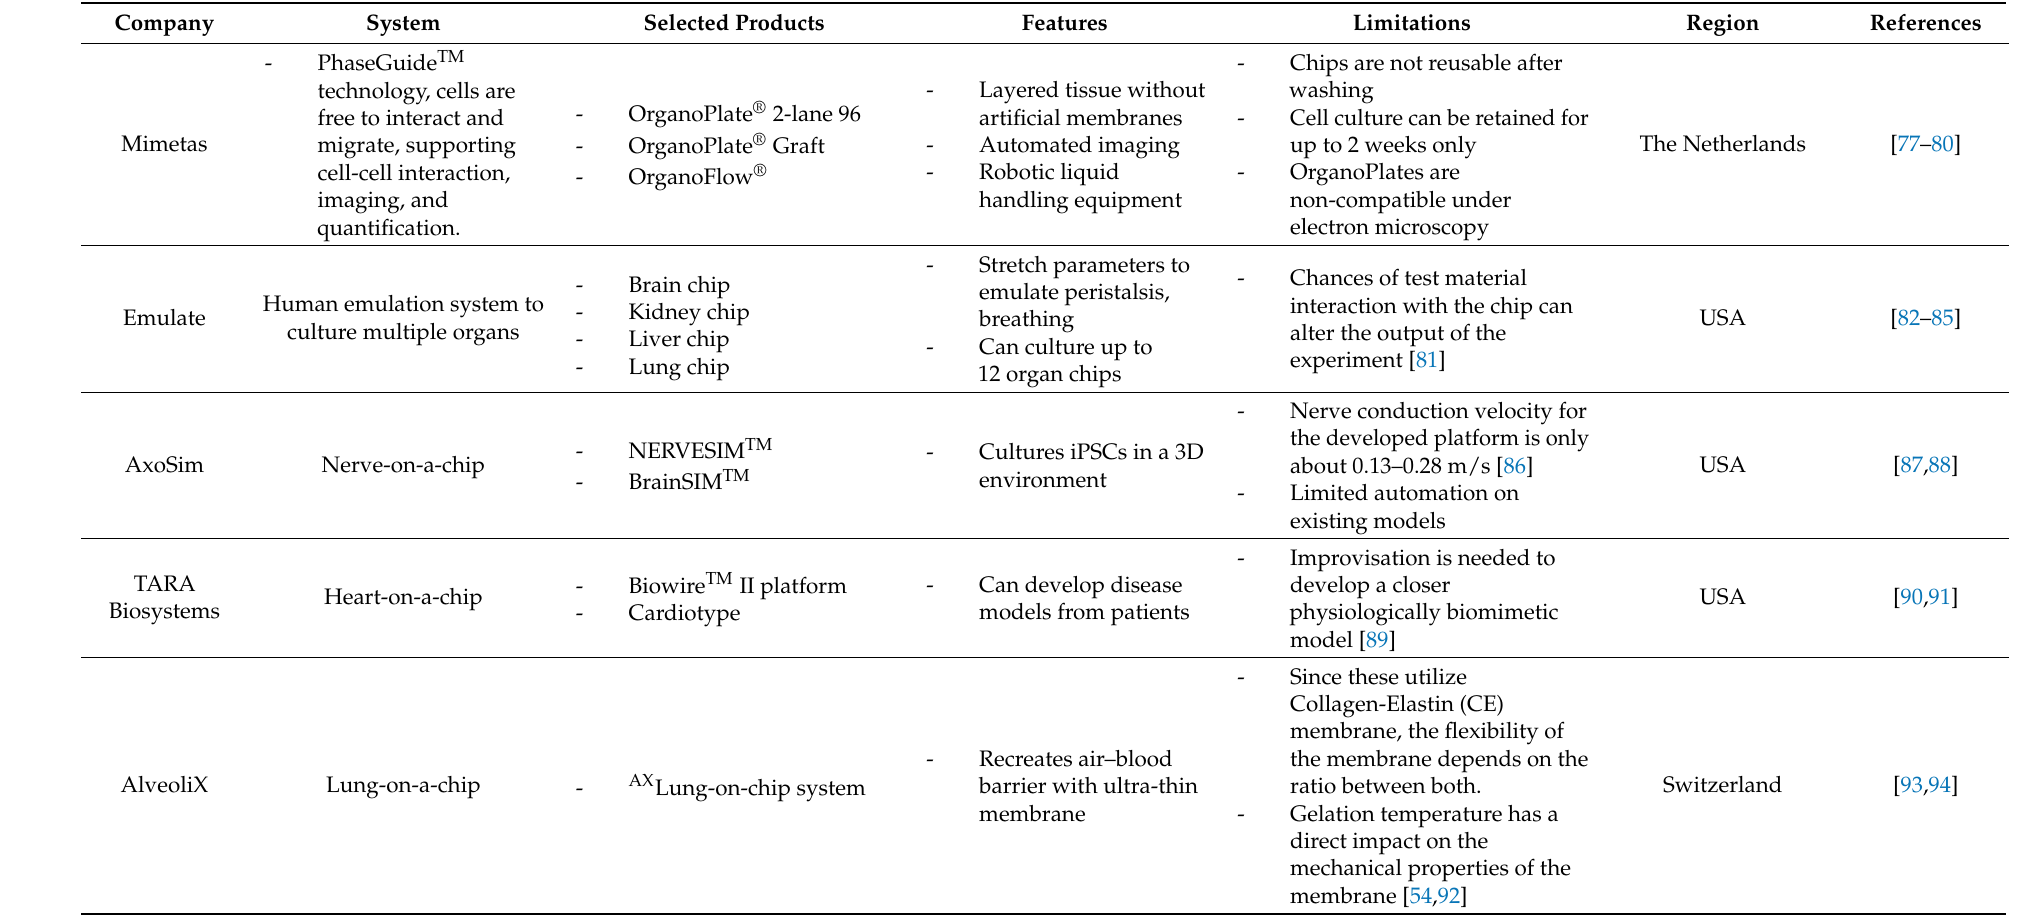
Table 3. Some of the leading OOAC